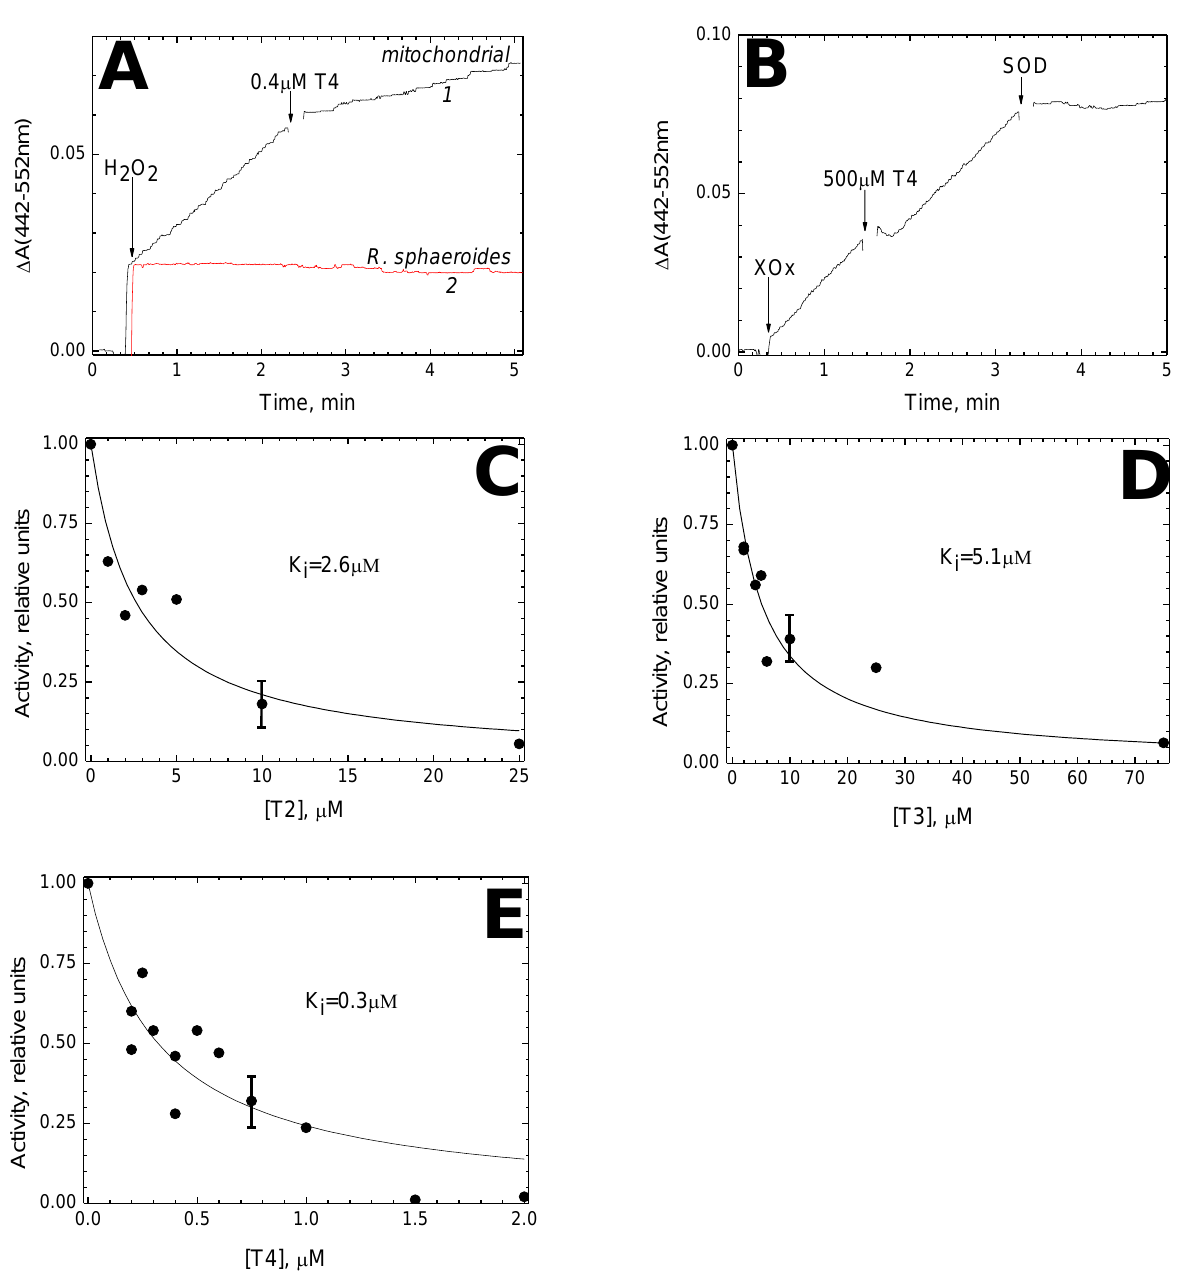
Figure 7. Thyroid hormones strongly inhibit superoxide generation by CcO in the presence of excess H 2 O 2 . ( A ) Typical kinetics of superoxide production catalyzed by mitochondrial CcO (trace 1, black) as compared to bacterial aa 3 -type oxidase from R. sphaeroides (trace 2 , red). Addition of 0.4 µM T4 is indicated. CcO was added up to 0.5 μM to the experimental medium, supplemented with 0.1 mM WST-1. The reaction was initiated by addition of 4 mM H 2 O 2 (indicated by the arrow). ( B ) T4 has no superoxide dismutase activity. Superoxide formation accompanying the oxidation of hypoxanthine (50μM) by xanthine oxidase (XOx, 0. 015 units/mL) was followed as in panel ( A ). Additions of 500 μM T4 and superoxide dismutase (SOD, 20 μg /mL) are shown by the arrows. ( C – E ) Concentration dependence of the inhibitory effect of thyroid hormones T2 ( C ), T3 ( D ) and T4 ( E ), respectively, on superoxide production by mitochondrial CcO. Conditions of the measurements are as in panel ( A ). Experimental data are approximated by function (1) with different values of the K i parameter (indi- cated).